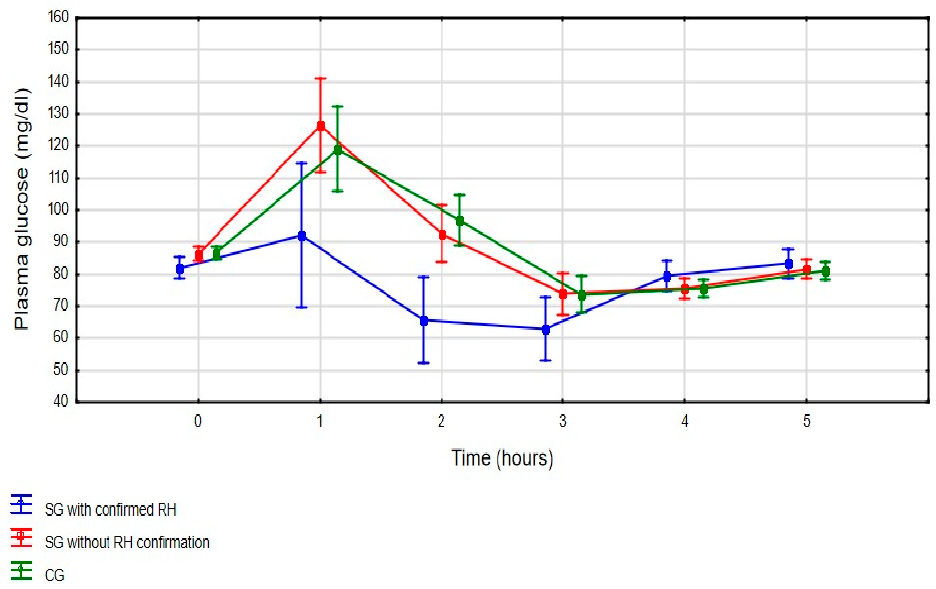
Figure 2. Mean glucose value during 5-h OGTT (three-way ANOVA: F (10, 360) = 3.598, p < 0.001) [mean glucose value with a 95% confidence interval]. SG—Study Group; CG—Control Group; RH—Reactive Hypoglycemia.